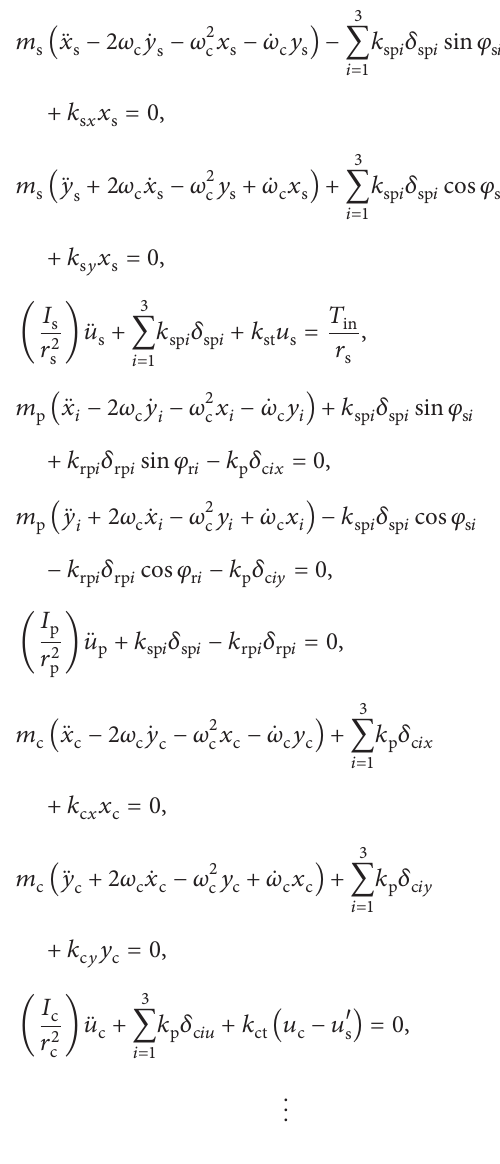
direction, and translational direction is determined by the respective coordinates.